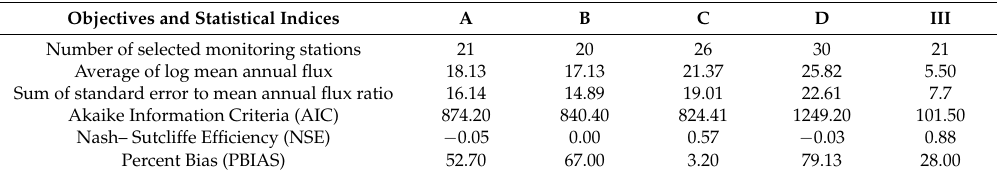
Table 1. Objectives and statistical indices for the alternative models (A–D) and Model